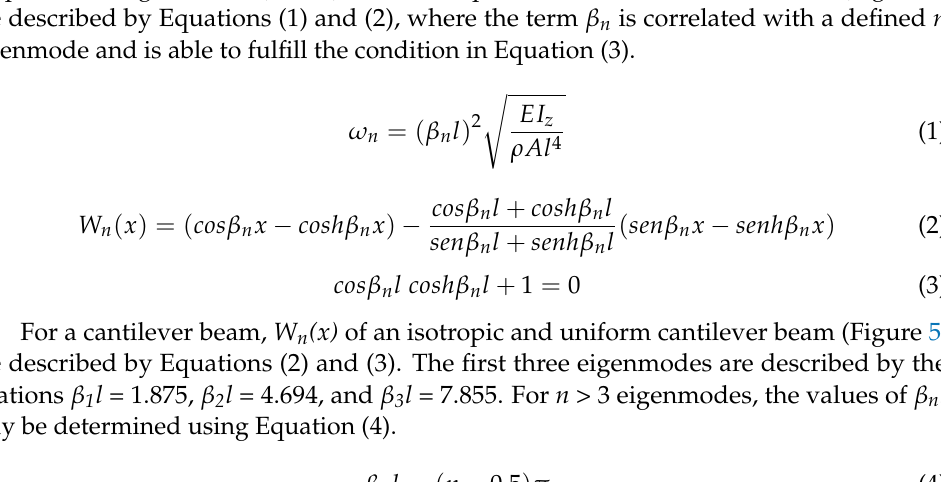
Figure 5. Detail of the numerical model showing the ( a ) boundary conditions and ( b ) meshing.